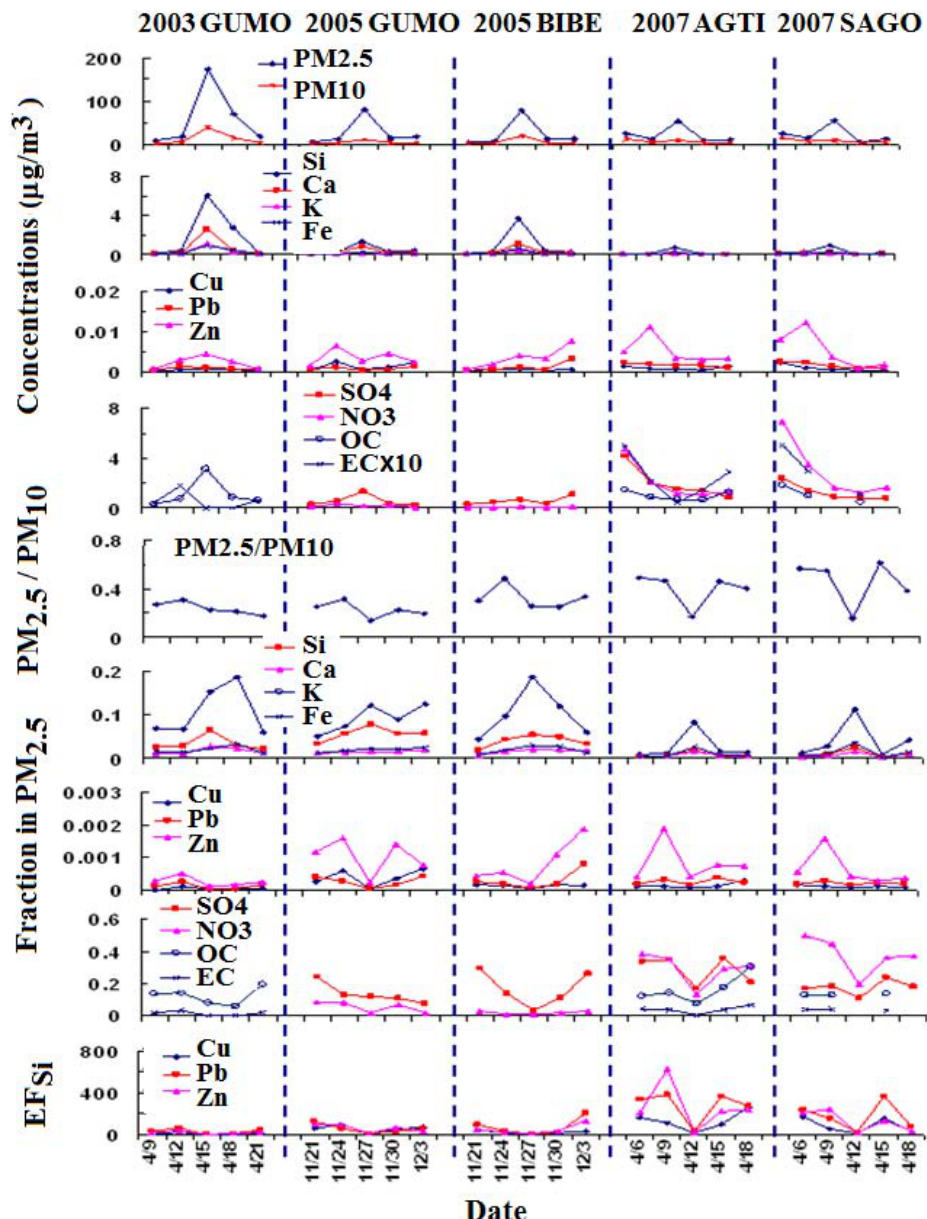
Fig. 2. Variations of PM 10 , PM 2 . 5 and chemical components of PM 2 . 5 at the BIBE1, GUMO1, AGTI1 and SAGO1 sites during, before and after three dust storms. These dust events have been pinpointed by MODIS satellite data. “Fraction in PM 2 . 5 ” indicates the fraction of the concerned aerosol component to total PM 2 . 5 mass, and EF Si indicates the enrichment factors of concerned species using Si as the referent